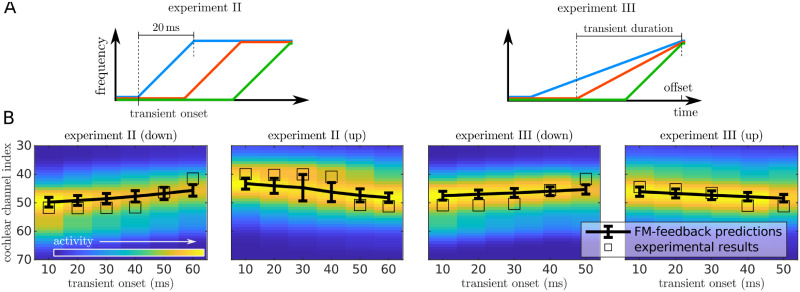
Predictions of the FM-feedback spectral model for Brady’s stimuli.A) Schematic view of the stimuli from [17]. In experiment II (left) the transient was fixed to a 20 ms duration and its onset was systematically varied so that the transition falls at different segments of the stimulus. In experiment III (right) the stimulus offset was fixed at 90 ms and the transient’s onset varied between 10 and 50 ms, resulting in transients of different durations. We extended the duration of these last stimuli to 95 ms to prevent the ramping at the end of the stimulus from overlapping with the FM transient. B) Model predictions. Heatmaps show the distribution of the activation across channels (y-axis) for different transient onsets (x-axis). Squares printed over the distributions mark the estimations of the experimental results in the channel space.